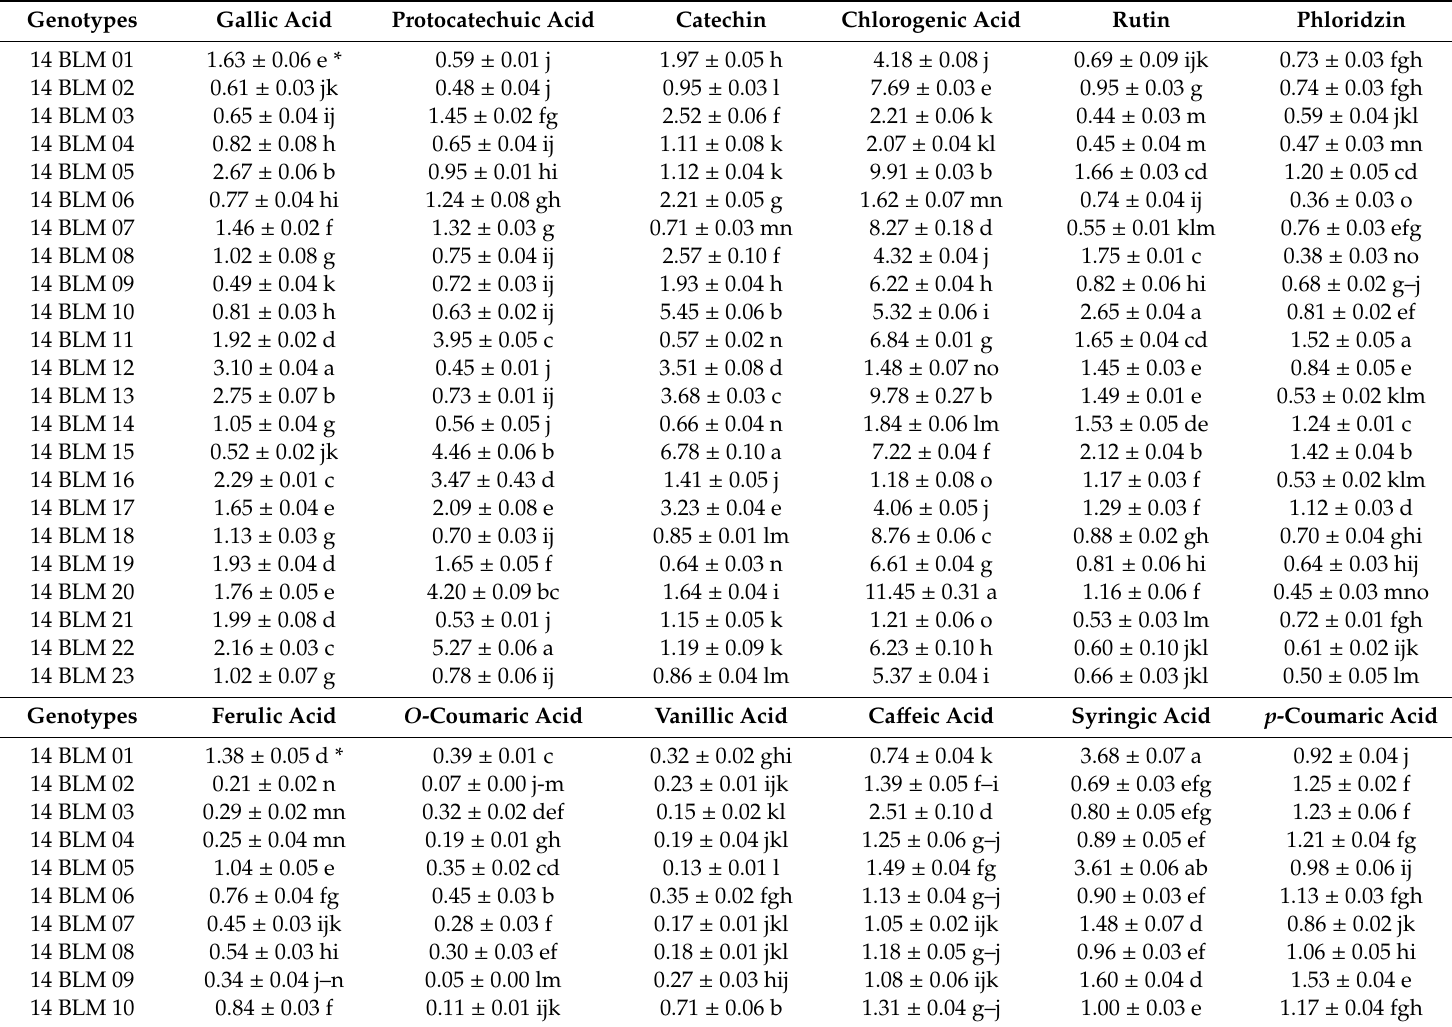
Table 4. Phenolic compounds of plum fruits (mg /